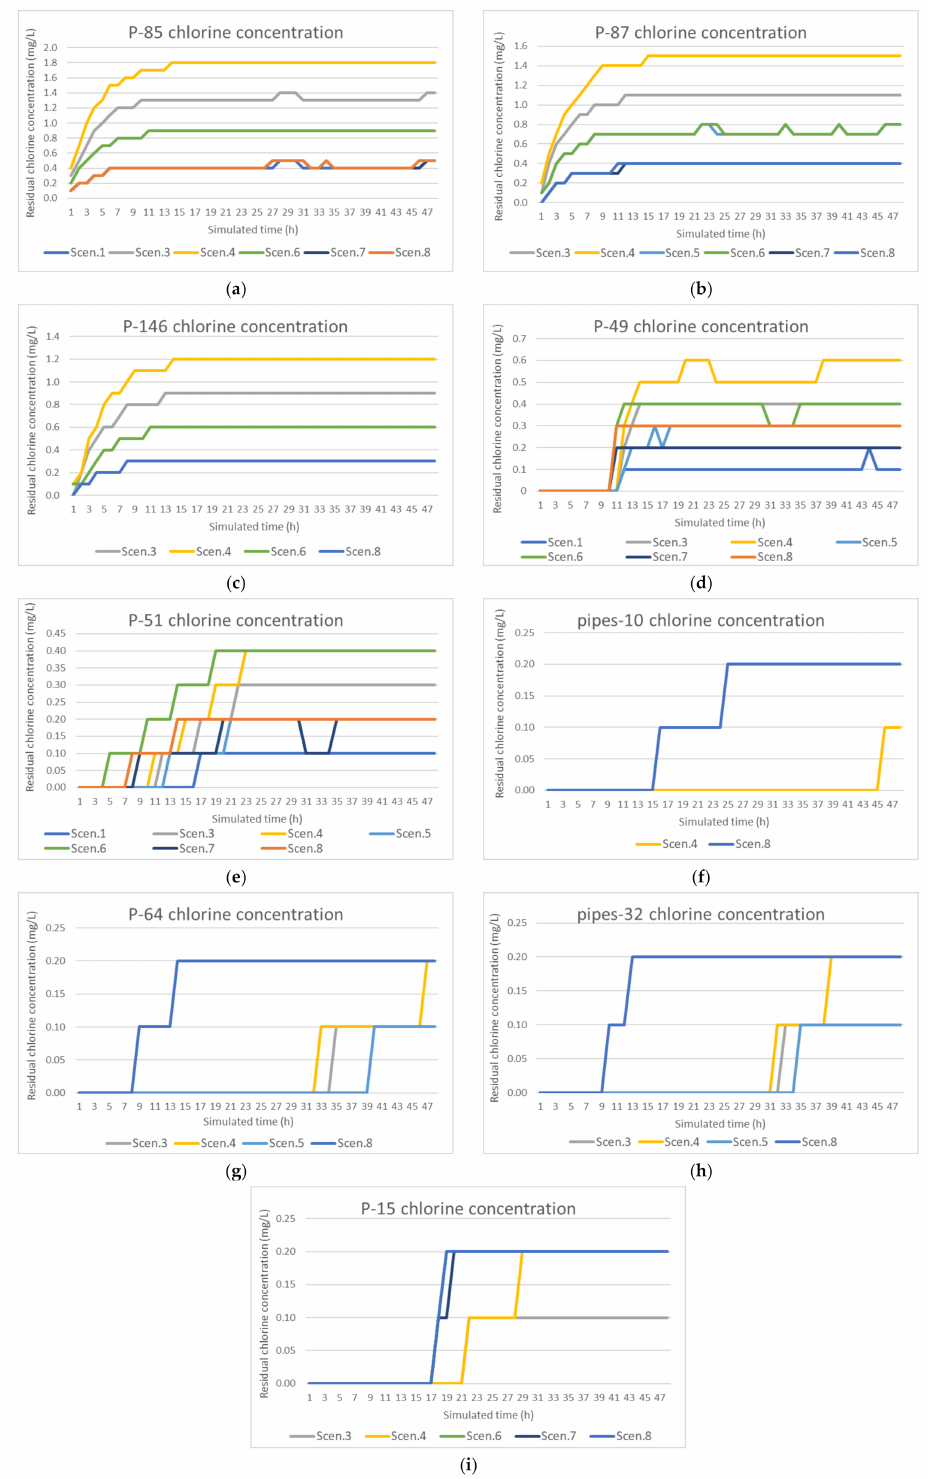
Figure 6. Residual chlorine concentration (mg/L) at the selected pipes during 48 h of operation (Scenario B). Specifically: ( a ) P-85; ( b ) P-87; ( c ) P-146; ( d ) P-49; ( e ) P-51; ( f ) pipes-10; ( g ) P-64; ( h ) pipes-32; and ( i )